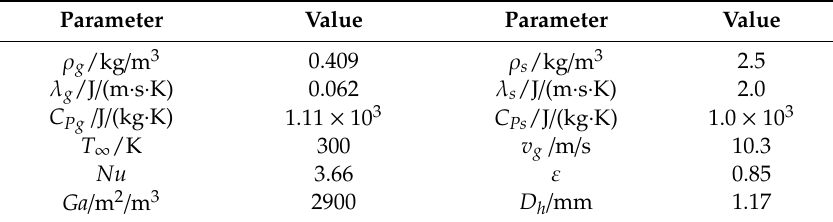
Table 4. Parameters used in the numerical model.